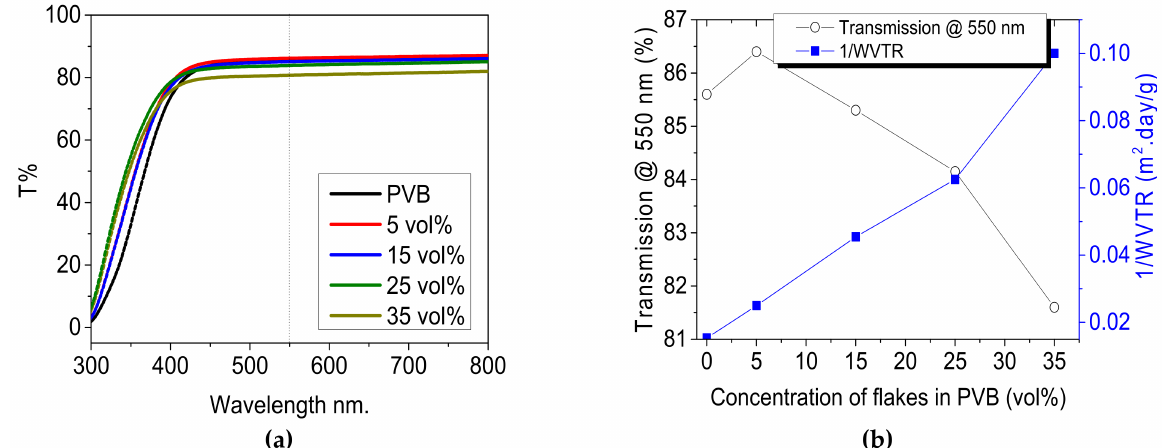
Figure 5. UV-vis spectra of PVB filled with mica at different concentrations. ( a ) Total transmittance spectra of PVB and its composite, ( b ) kinetics of decrease of transmittance @ 550 nm (open circle in black) for PVB filled with 5 vol% to 35 vol% of mica with corresponding 1/WVTR values (closed square in